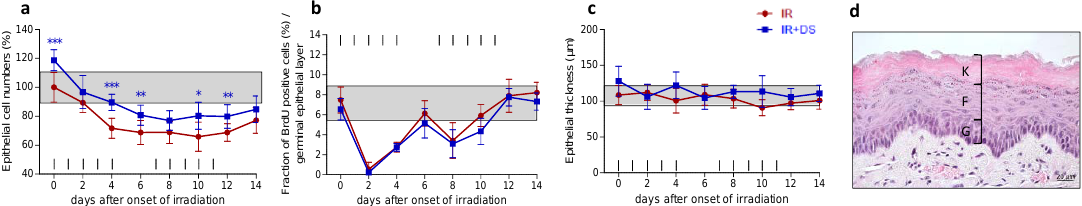
Figure 1. Effect of DS on irradiation-induced changes of epithelial morphology and proliferation. Epithelial cell numbers ( a ); proliferation ( b ) and epithelial thickness ( c ) were assessed over the course of 14 days of fractionation with a daily dose of 3 Gy without and with additional systemic DS treatment. The epithelium is composed of a germinal layer (G), a functional layer (F) and a fully keratinized superficial layer (K). Cell number and proliferation were assessed in the germinal and the functional layer. To evaluate the epithelial thickness, germinal, functional and keratinized layer dimensions were combined ( d ). Data points represent the mean of 5 animals, error bars indicate ±1 standard deviation (SD). The shaded areas illustrate the mean (±1 SD) from 5 control animals. The fractionation protocol is indicated on top of the abscissae. * p ≤ 0.05, ** p ≤ 0.01, *** p ≤ 0.001, Scale bar = 20 µm.